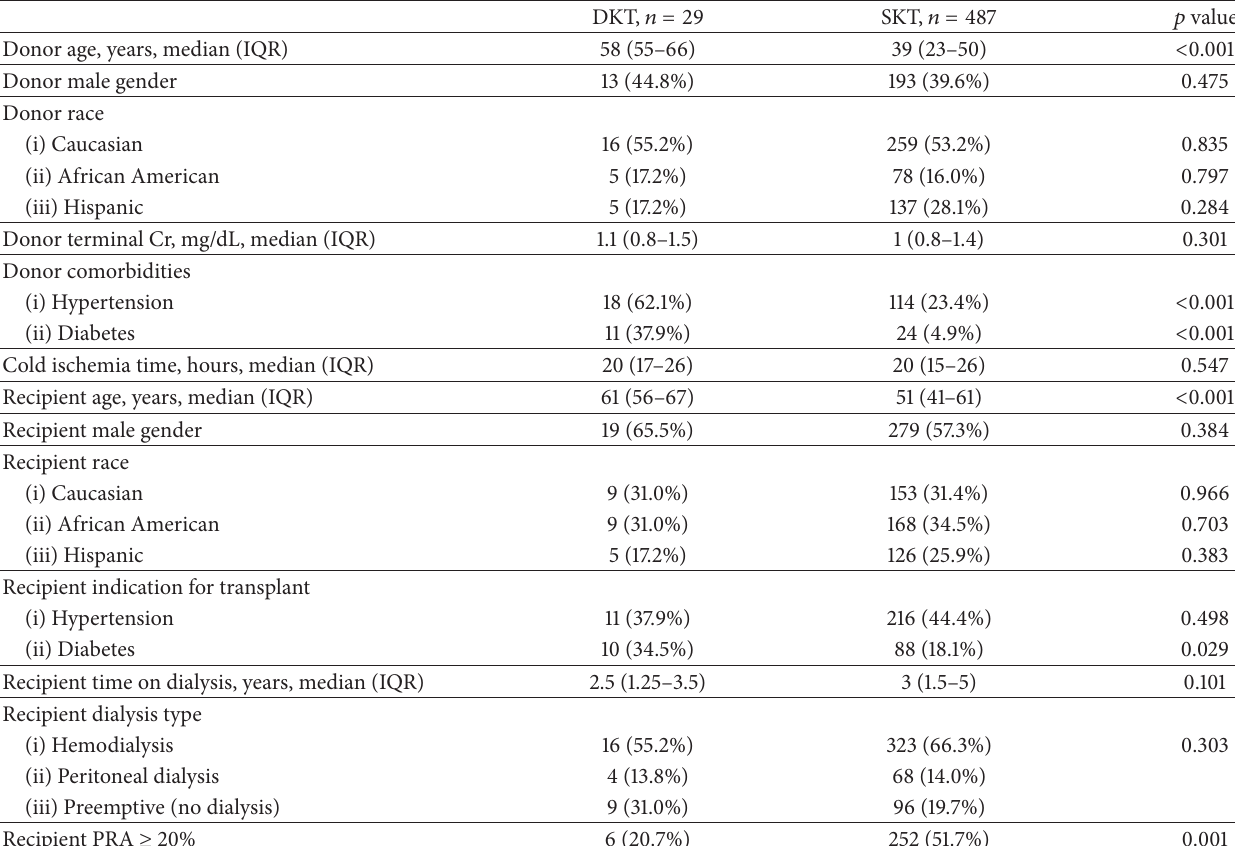
Table 1: Pretransplant demographic data for dual (DKT) and single-kidney transplant (SKT) recipients.